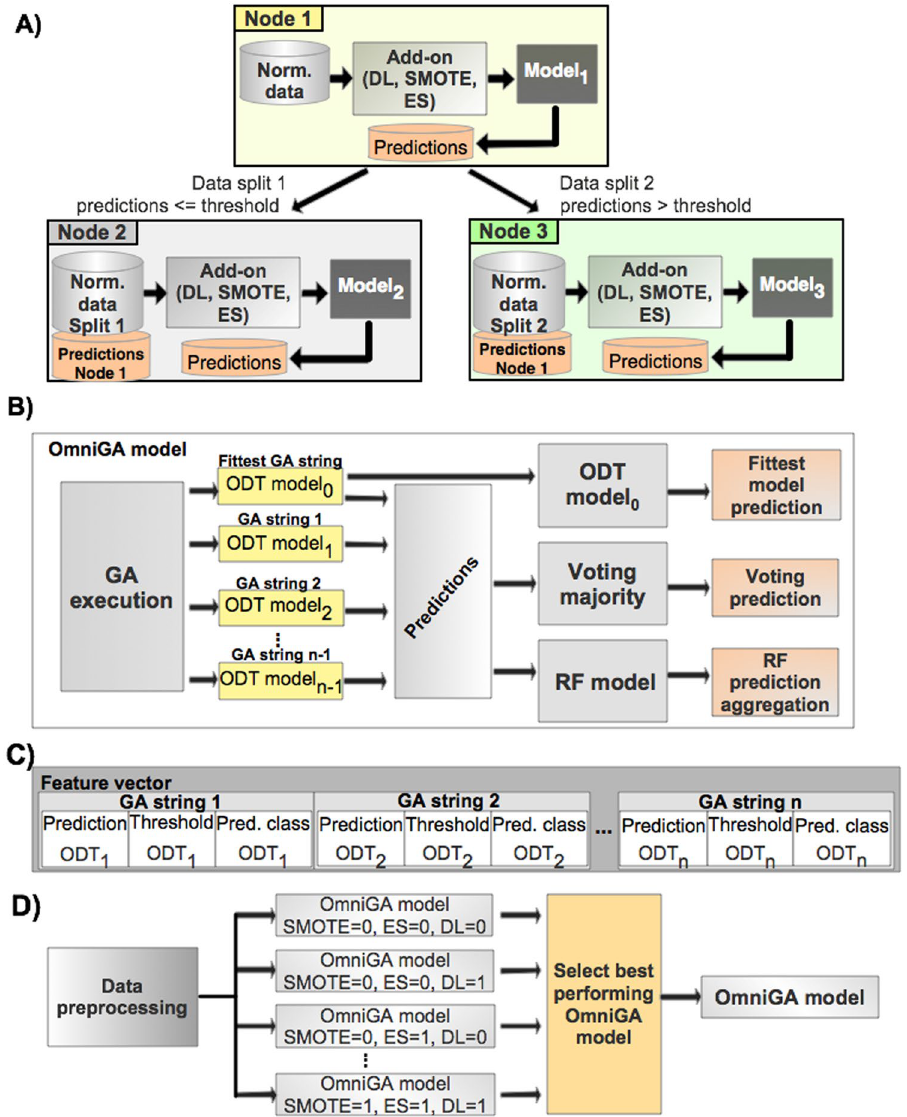
Figure 5. Illustration of the ODT structure and the OmniGA framework. ( A ) Schematic representation of the method followed for each non-terminal node in the ODT. ( B ) Induction process for an OmniGA model. ( C ) Illustration of the feature vector used for the deep learning module in the OmniGA model. ( D ) OmniGA framework consisting of eight OmniGA models using different add-on